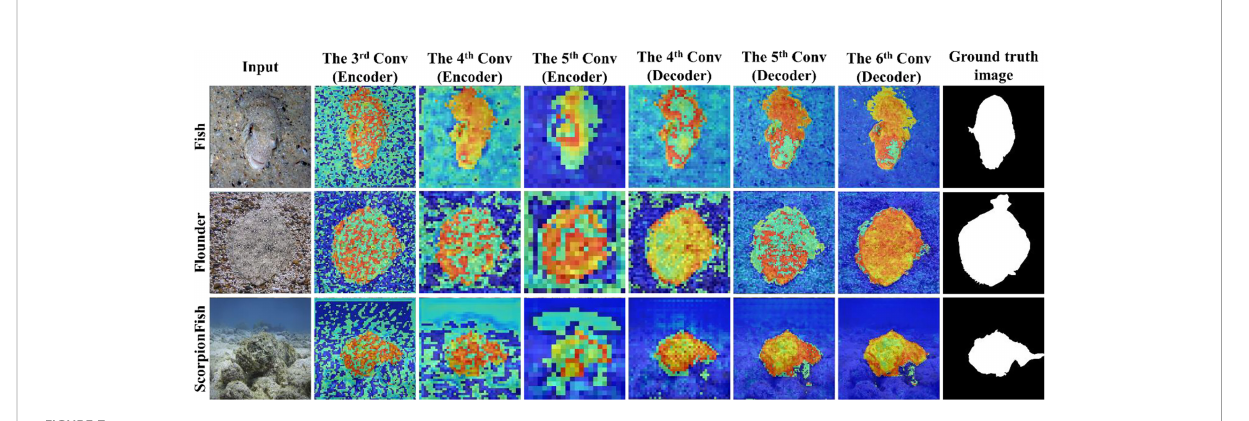
FIGURE 7 Examples of attention feature maps using MAS3K dataset (case 2).